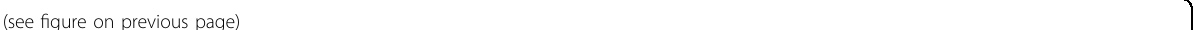
Fig. 5 EP4 antagonists prevented cartilage ECM breakdown by promoting ECM generation and inhibiting cartilage catabolism in human articular cartilage. a HL-43 prevented cartilage ECM degradation. The relative intact non-weight-bearing explants of human cartilage were isolated from knee OA patients undergoing total knee replacement. S.O. staining of OA patient cartilage explants after 7 days of treatment with Celecoixb, Grapiprant, and HL-43 at indicated dosage. Scale bars, 200 μ m. Veh, vehicle. b Proteoglycan staining area (%) was measured by S.O. staining. Error bars are means ± s.d., n ≥ 4 for each group. c Release of total glycosaminoglycan (GAG) into the media of human articular cartilage explant was measured by 1,9-dimethylmethylene blue (DMMB) assays. Human articular cartilage explants were treated with the indicated chemical compounds for 7 days. The secreted GAG was normalized to the wet weight of the cartilage explant to calculate the release of GAG, then normalized to vehicle. Error bars are means ± s.d., n = 3 for each group. d qRT-PCR analysis of anabolic factors COL2A1 , ACAN , SOX9 , and MMP13 expressed in the human articular cartilage explants treated with 1 ng/ml IL-1 β and indicated chemical compound for 24 h (Celecoxib 10 μ M, Grapiprant and HL-43 30 μ M). e Representative images of immunohistochemistry staining of indicated antibodies in vehicle, Celecoxib, Grapiprant, HL-43 treated human cartilage explants, scale bars, 100 μ m. * P < 0.05, ** P < 0.01, *** P < 0.001, **** P < 0.0001 by one-way ANOVA with multiple comparison using Tukey method. ns, not signi fi cant; Veh,